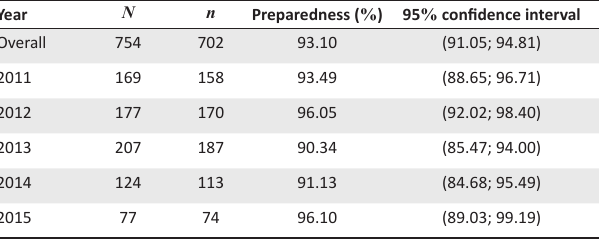
TABLE 1: Proportion of medical students who feel adequately prepared for their role as medical practitioners, overall and by year. Year N